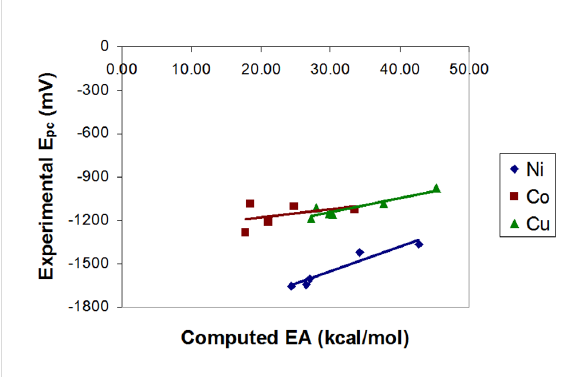
Figure 2: Correlation between electron affinity (EA) and Hammett σ p parameter in the training set (R 2 = 0.76, 0.72, and 0.81 for Ni, Co, and Cu, respectively).